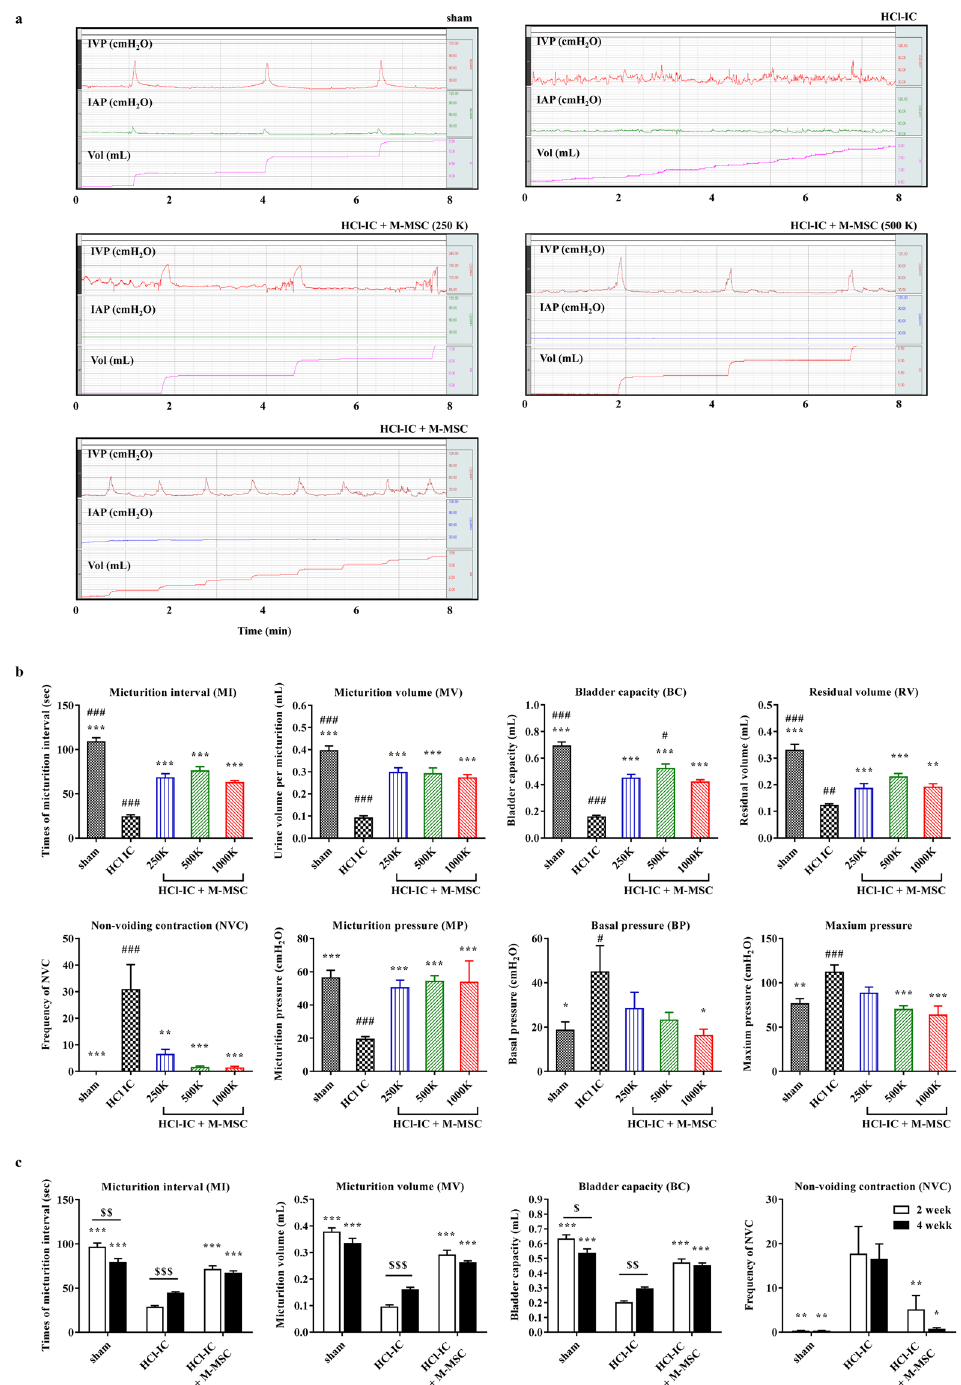
Figure 2. M-MSC injection restored bladder function in HCl-IC model rats. ( a ) Representative awake cystometry results and ( b ) quantitative bladder voiding parameters at 1 week after the injection of M-MSCs (8 independent animals in each group) at the indicated dosage (K = a thousand). IVP; intravesical pressure, IAP; intra-abdominal pressure. Sham: sham-operated. ( c ) Quantitative data of bladder voiding parameters at 2 or 4 weeks after the injection of 1 × 10 6 M-MSCs (5 independent animals per group). All data are presented as the mean ± SEM, * p < 0.05, ** p < 0.01, *** p < 0.001 compared to the HCl-IC group; # p < 0.05, ## p < 0.001, ### p < 0.001 compared to the 1000 K group; $p < 0.05, $$p < 0.001, $$$p < 0.001 between 2 and 4 weeks group with Bonferroni